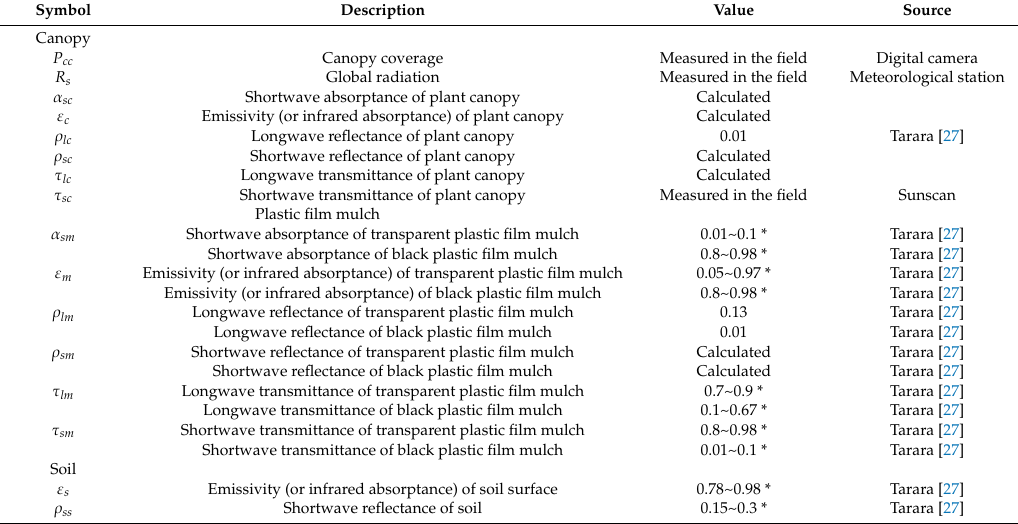
Table 1. Input parameters for the net radiation calculation using in modeling the interaction of plastic film mulch and potato canopy growth on soil heat